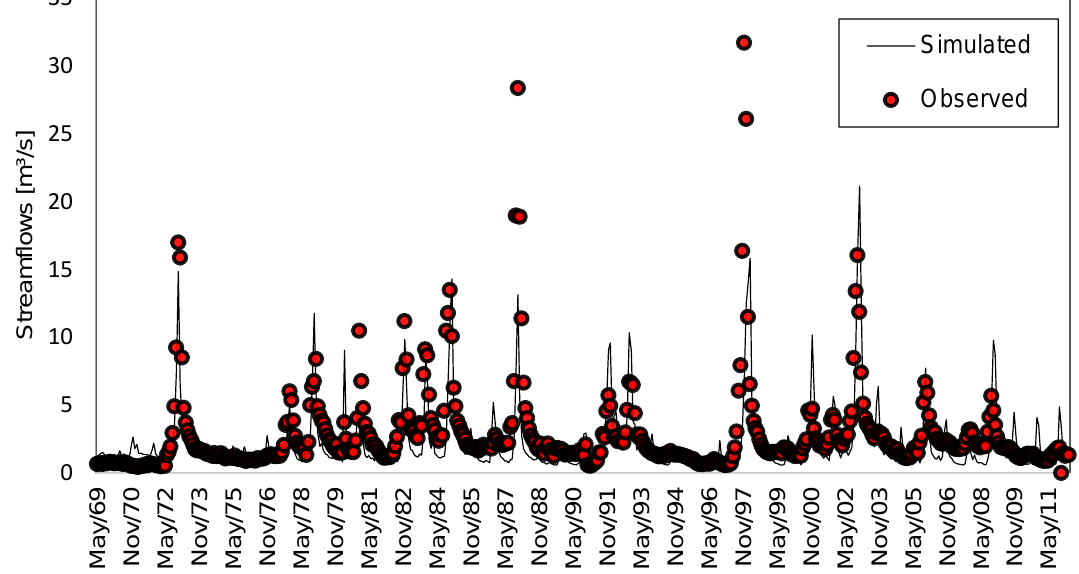
Figure 3. Observed vs. simulated monthly discharges for the period 1969–2011 at the San Agustin gauge in the Hurtado River.